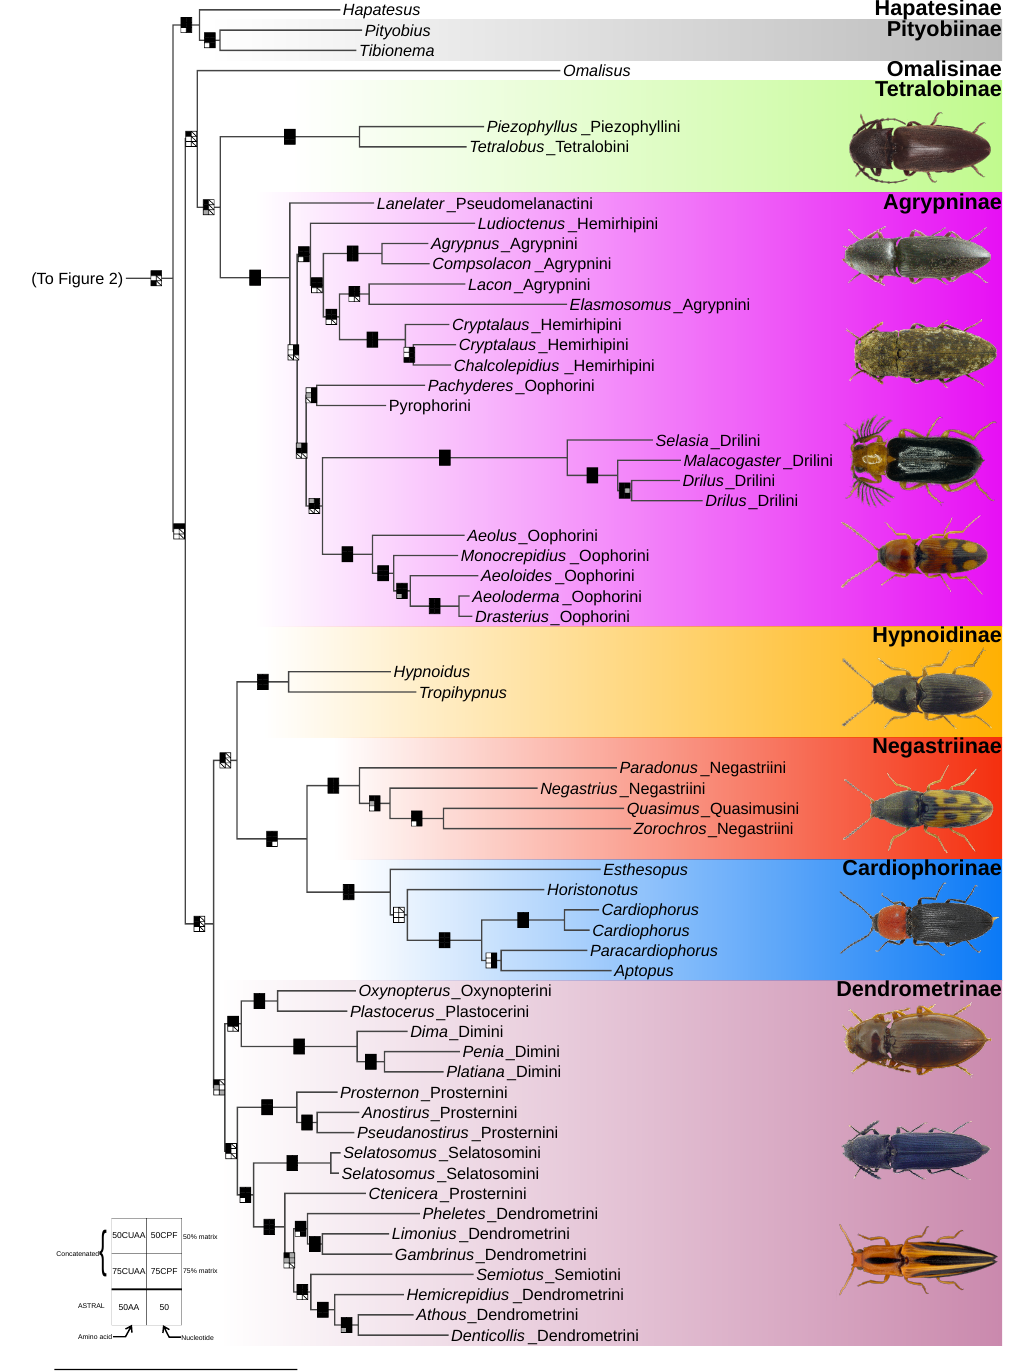
Figure 3. Phylogeny of the Elateroidea inferred from unpartitioned maximum-likelihood analysis of the 50% completeness amino acid matrix (50CUAA—958 loci). Node boxes correspond to individual analyses, as shown in the lower-left key and are shaded according to support: black—strong; gray—weak; white—unsupported; slash—strong support for an alternate topology. Beetle images from top to bottom: Tetralobinae ( Piezophyllus sp.), Agrypninae ( Lanelater persicus (Cand è ze, 1874), Agrypnus murinus (Linnaeus, 1758), Selasia sp., Drasterius bimaculatus (Rossi, 1790)); Hypnoidinae ( Hypnoidus consobrinus (Mulsant and Guillebeau, 1855)), Negastriinae ( Negastrius sabulicola (Boheman, 1854)), Cardiophorinae ( Cardiophorus gramineus (Scopoli, 1763)), Dendrometrinae ( Dima elateroides Charpentier, 1825, Gambrinus violaceus (Müller, 1821), Semiotus furcatus (Fabricius, 1792)). All images, except Piezophyllus sp., Selasia sp. and Semiotus furcatus , are from www.elateridae.com with permission (accessed on 8 January